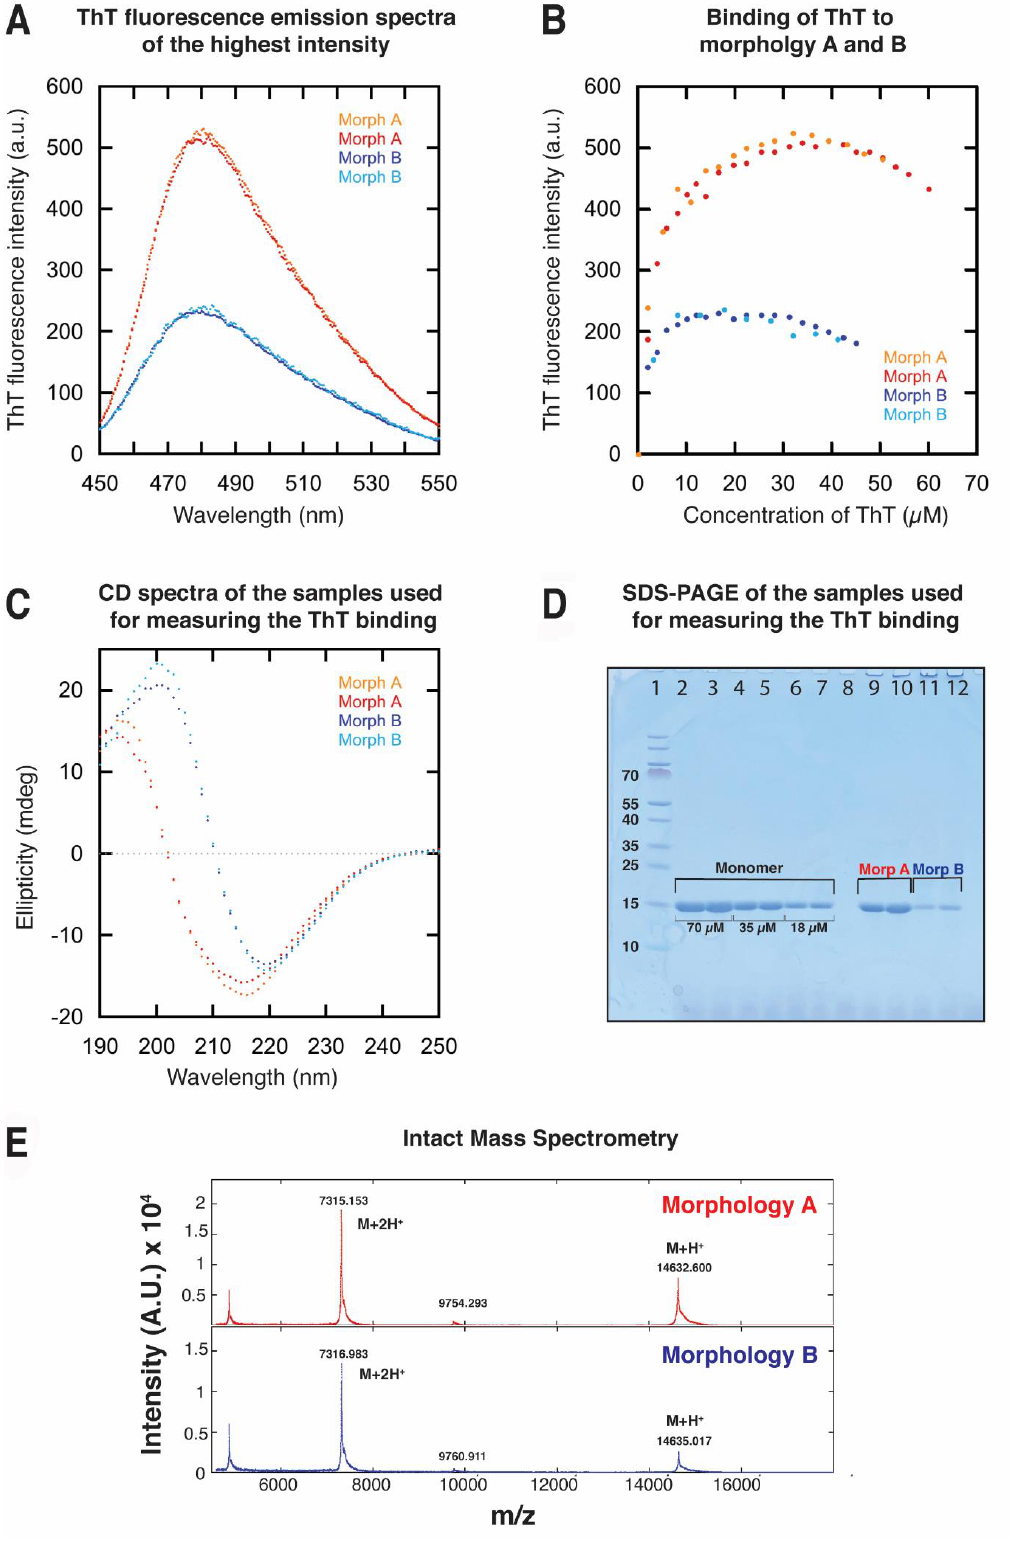
Figure 6. Investigation of surface properties of morphologies A and B by measuring binding of ThT. ( A ) ThT fluorescence emission spectra of morphologies A and B, showing the full emission spectra of the highest intensity. The emission spectra of two individual samples are shown for each morphology: morphology A (orange and red) and morphology B (dark and light blue). For morphology A, the